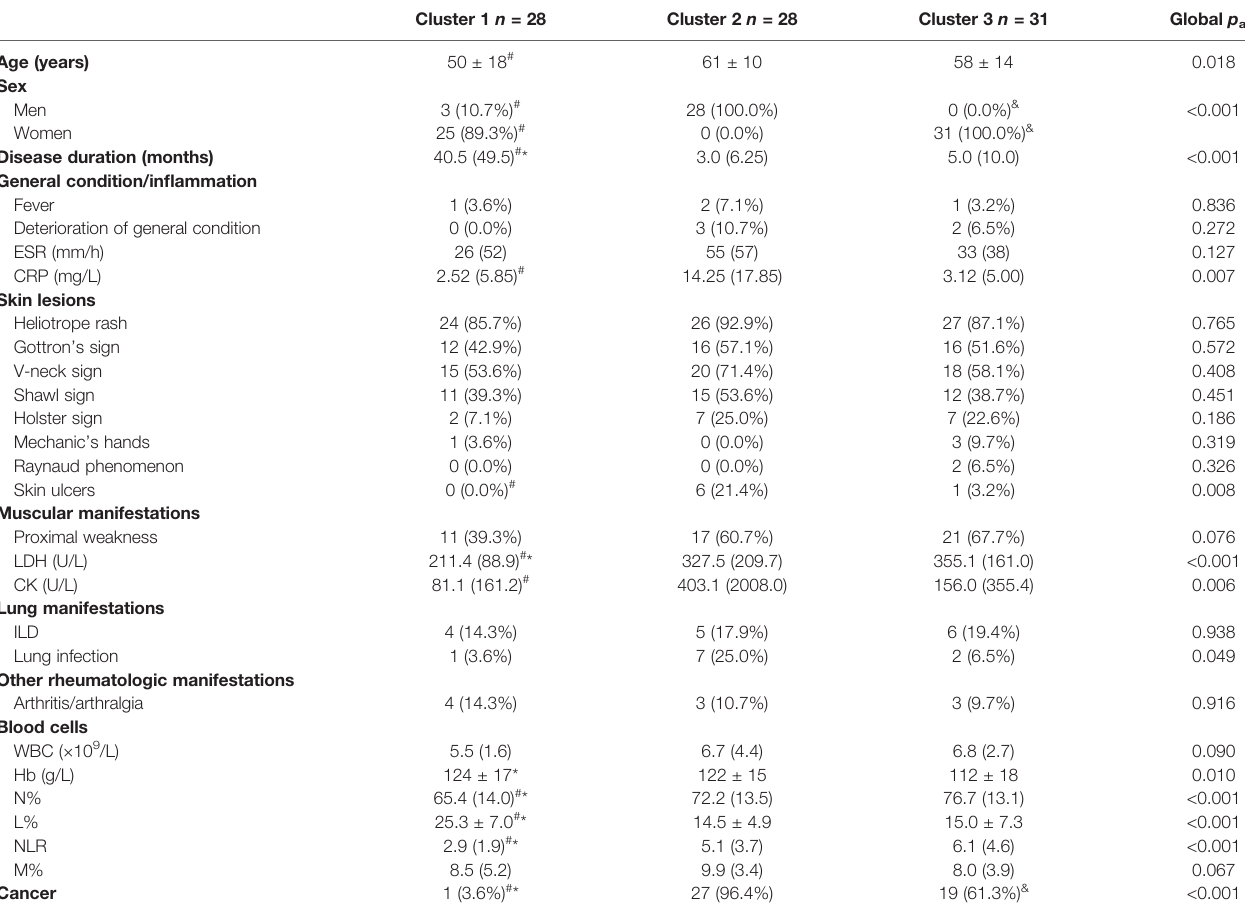
TABLE 1 | Characteristics of anti-TIF1 g + myositis patients among three clusters at the time of fi rst visit at our